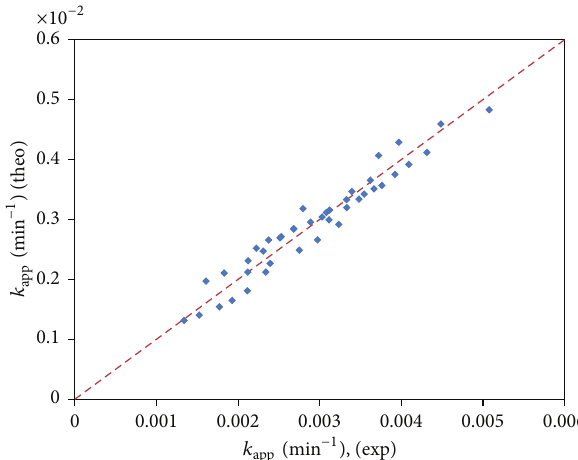
Figure 11: Comparison between the experimental and theoretical values of apparent rate